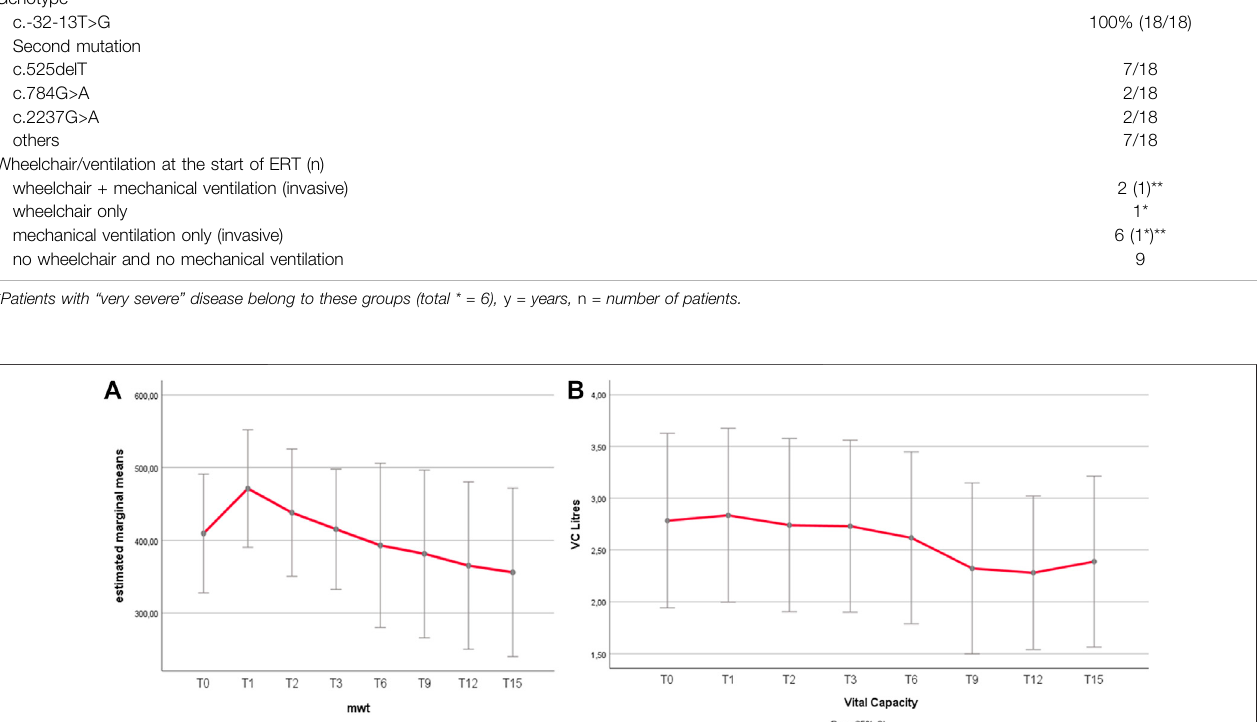
TABLE 1 | Main demographic and disease features of 18 patients on ERT. ERT follow-up duration, median (IQR, range) (y)